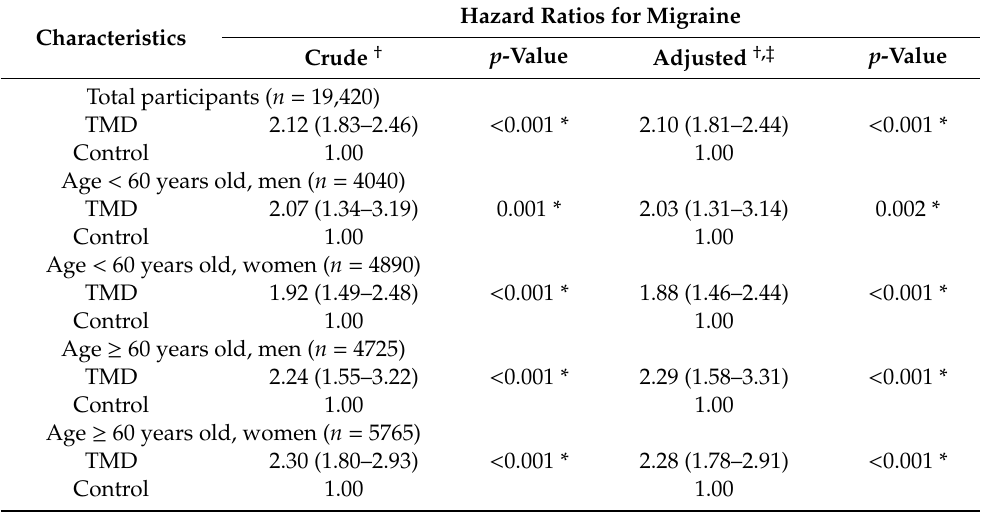
Table 2. Crude and adjusted hazard ratios (95% confidence interval) for migraine in temporomandibular disorder and control groups.